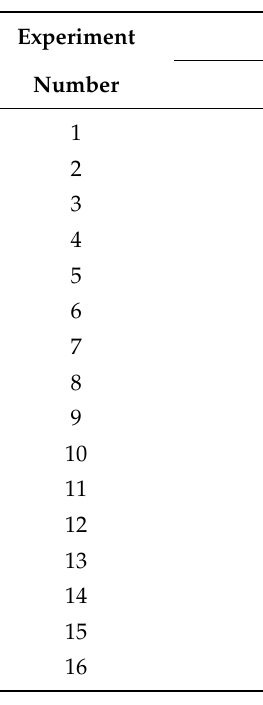
Table 2. Orthogonal Arrays and HV